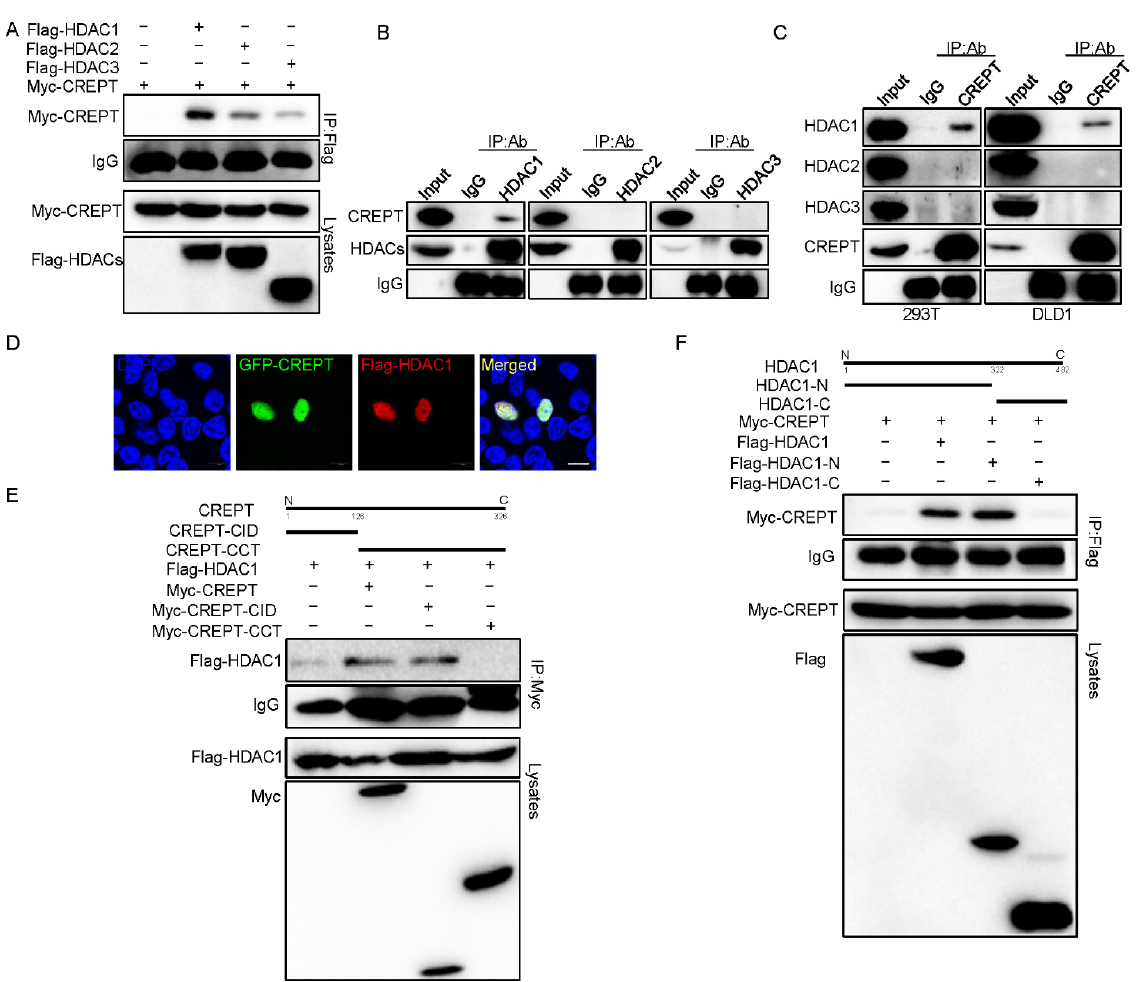
Figure 3. HDAC1 specifically interacts with CREPT. ( A ). Flag–HDAC1 interacts with Myc–CREPT. Myc–CREPT (3 µ g) and Flag–HDAC1/2/3 (3 µ g) were co-transfected into HEK293T cells for im- munoprecipitation experiments. Antibodies used are indicated. ( B , C ). HDAC1 interacts with CREPT endogenously. Nuclear extracts were immunoprecipitated with an antibody against HDAC1/2/3 ( B